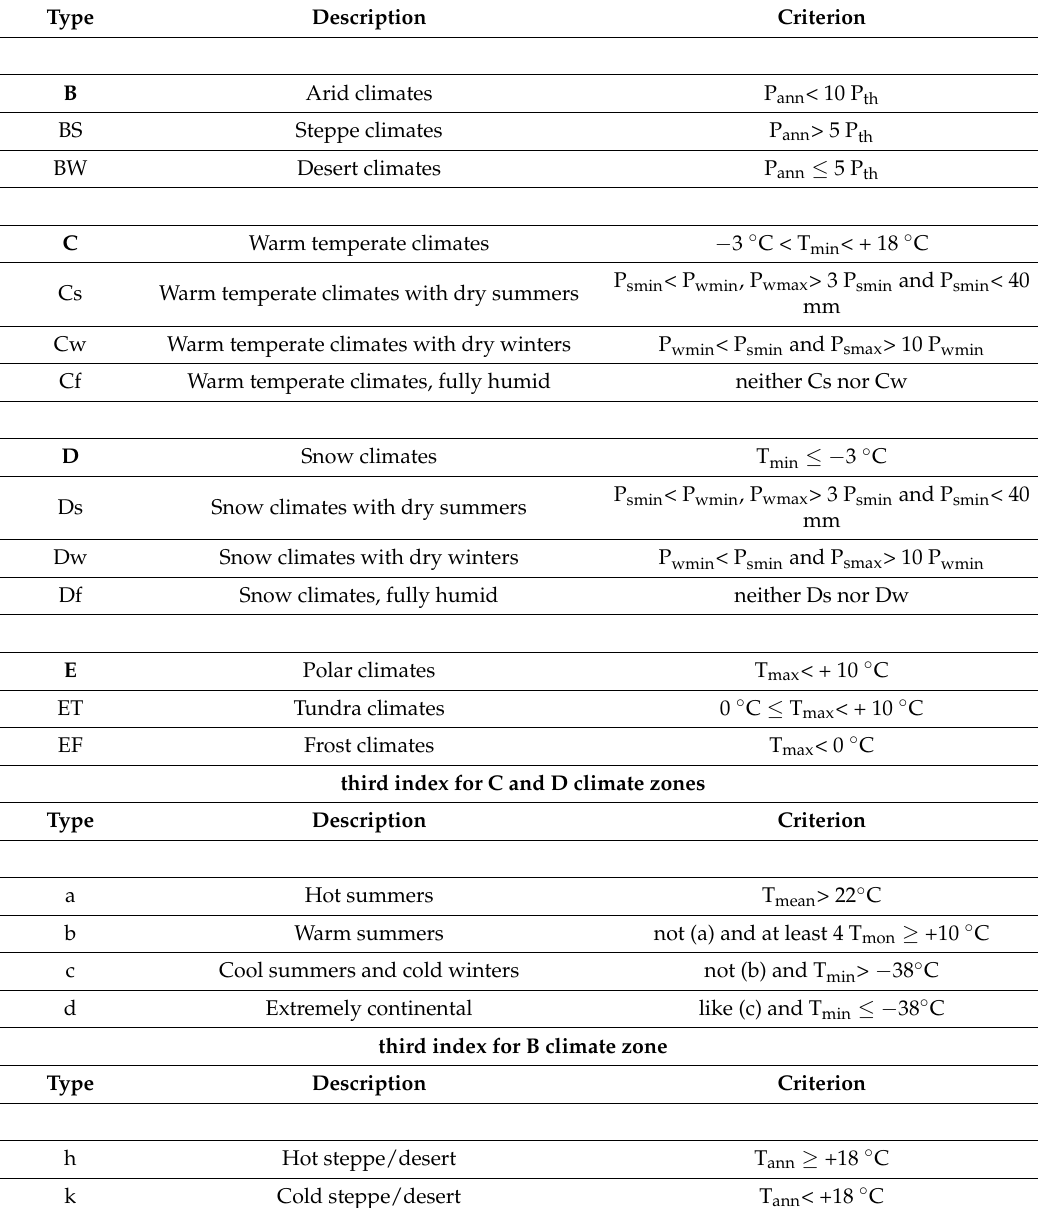
Table 1. Key to calculate K-G zones in Europe and their third index. Pann is the accumulated annual precipitation. Pmin is the precipitation of the driest month. Psmin, Psmax, Pwmin and Pwmax are defined as the lowest and highest monthly precipitation values for the summer and winter half-years. Pth is the dryness threshold. Tann is the annual mean temperature, and the monthly mean temperatures of the warmest and coldest months are marked by Tmax and Tmin, respectively. The precipitation and temperature are given in mm and ◦ C,